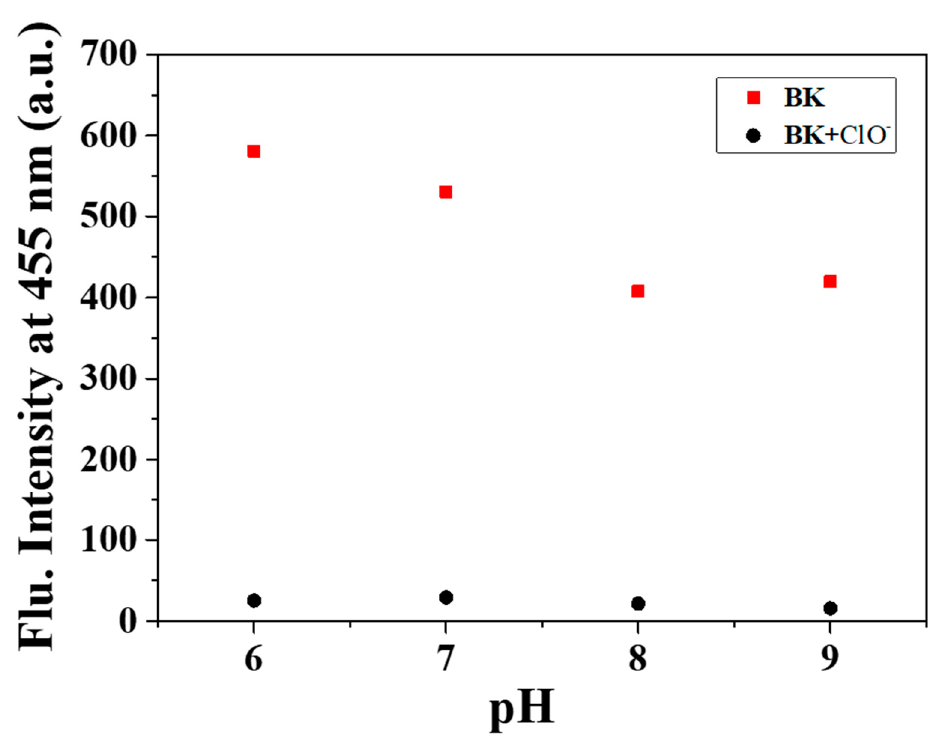
Figure 7. Fluorescence intensity (at 455 nm) of BK with ClO − at pH values from six to nine. Table 1. Determination of ClO − .